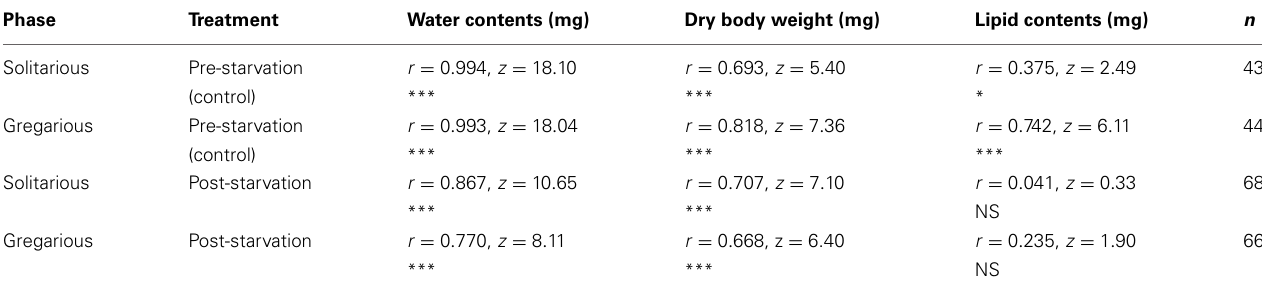
Table 3 | Matrices of statistical correlation (Pearson correlation, r , z -value) between fresh body weight (mg) and water contents (mg), dry body weight (mg) or lipid contents (mg) for Schistocerca gregaria hatchlings from either isolated-reared (solitarious) or crowd-reared (gregarious)